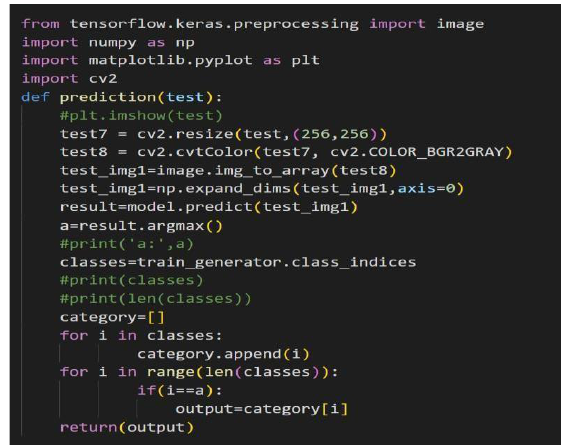
Fig15. Prediction Funtion